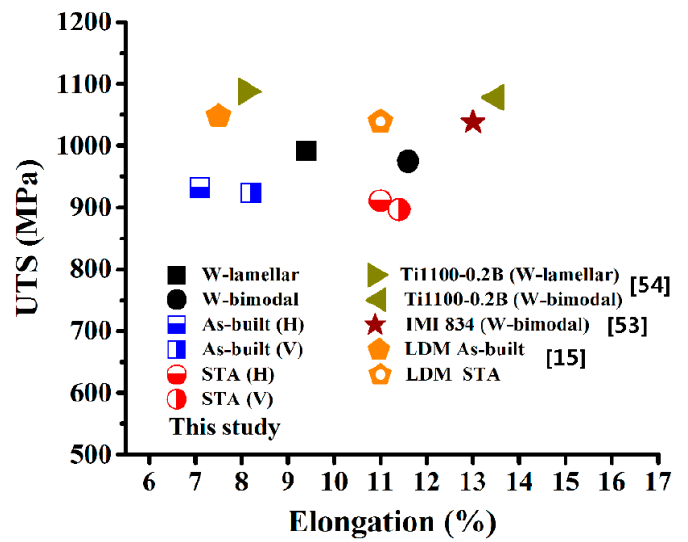
Figure 11. Comparison of the ultimate tensile strength and elongation at room temperature of the